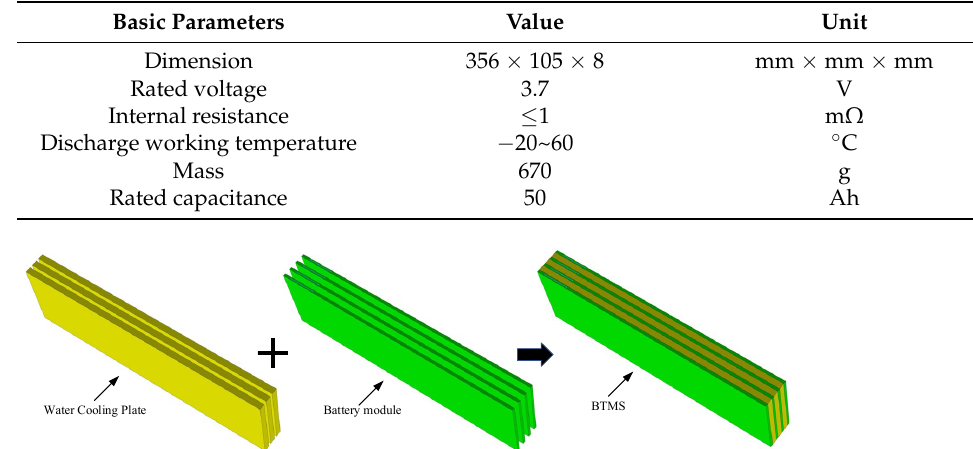
Figure 1. The picture of TLP80A5E6-50AH LIB. Table 1. LIB’s basic parameters.